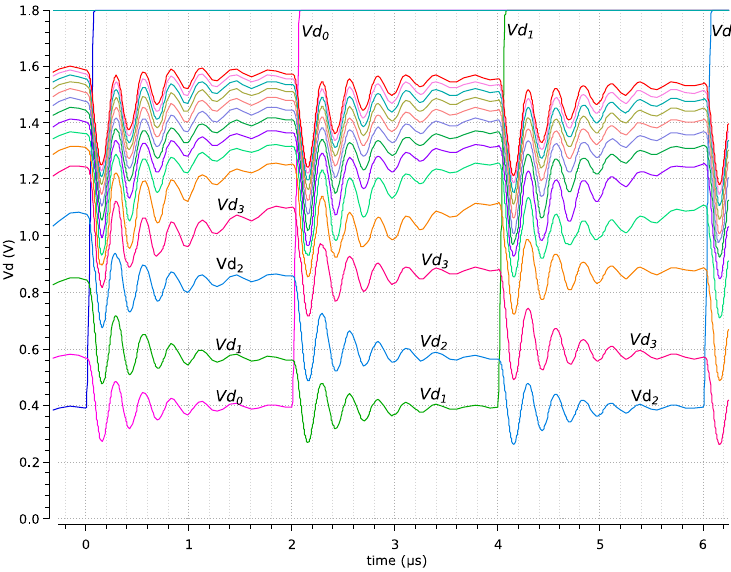
Figure 5. Normal WTA operation of successive losing pixels.